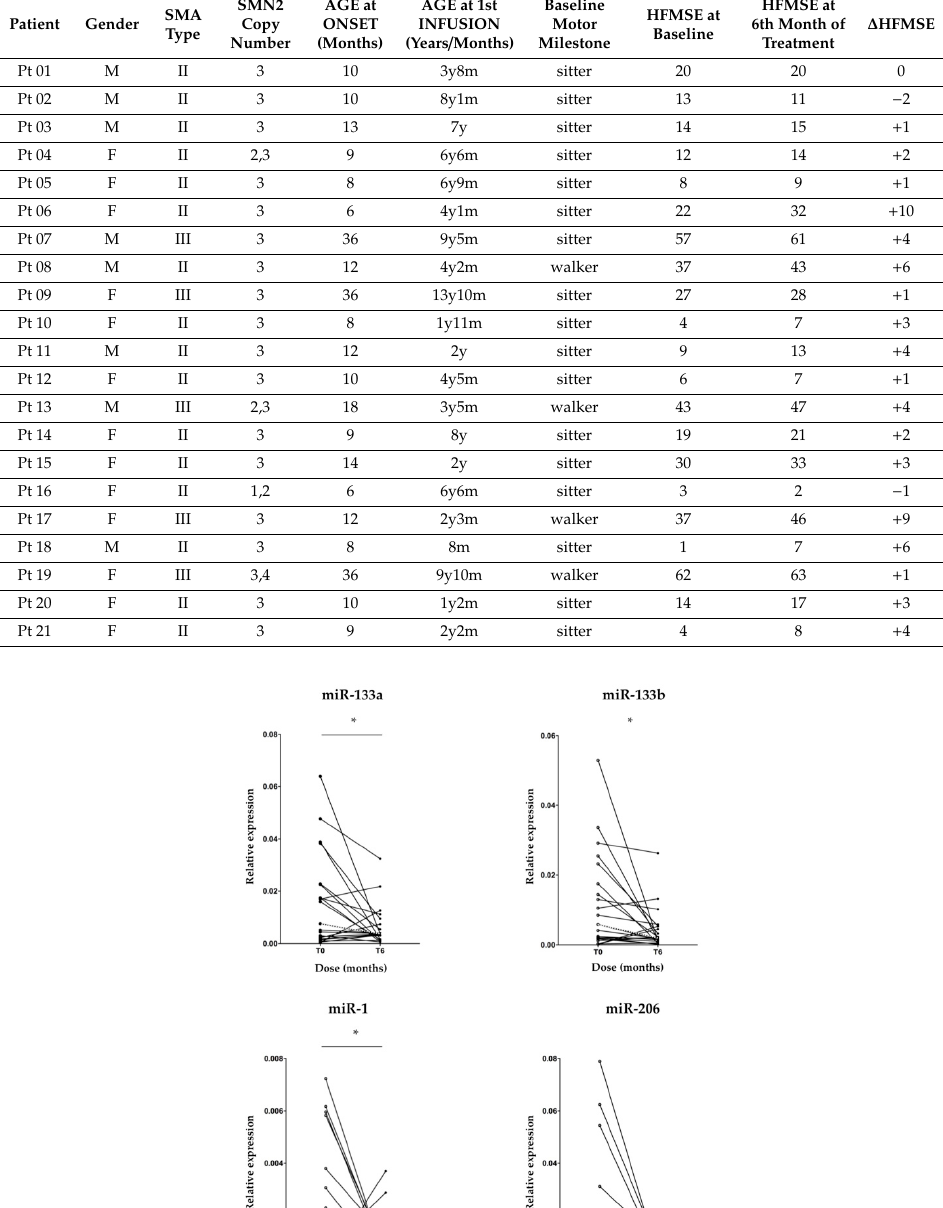
Table 2. Clinical features and motor function evaluations of SMA patients before (T0) and after (T6) nusinersen treatment.